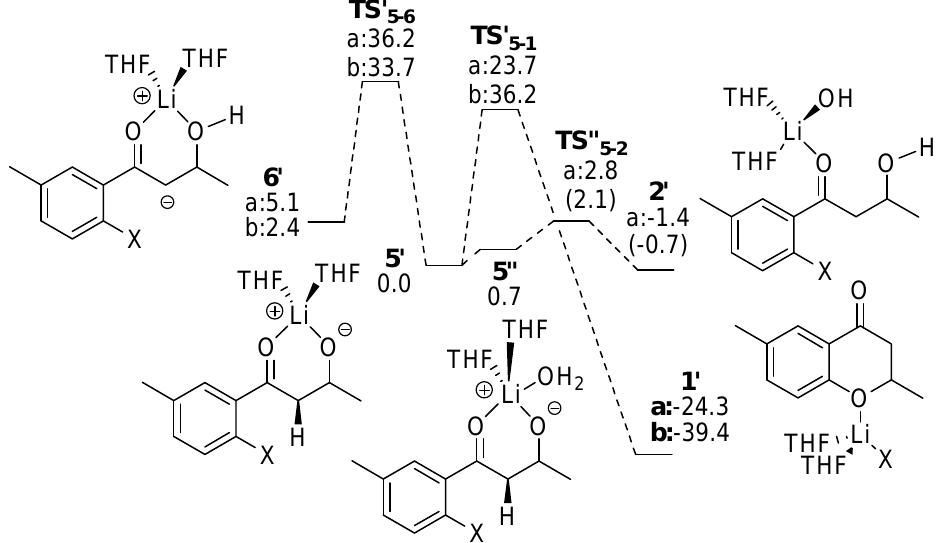
Figure 1. Energy correlation diagram (kcal mol -1 ) and TS structures (lengths in Å) related to Routes A and